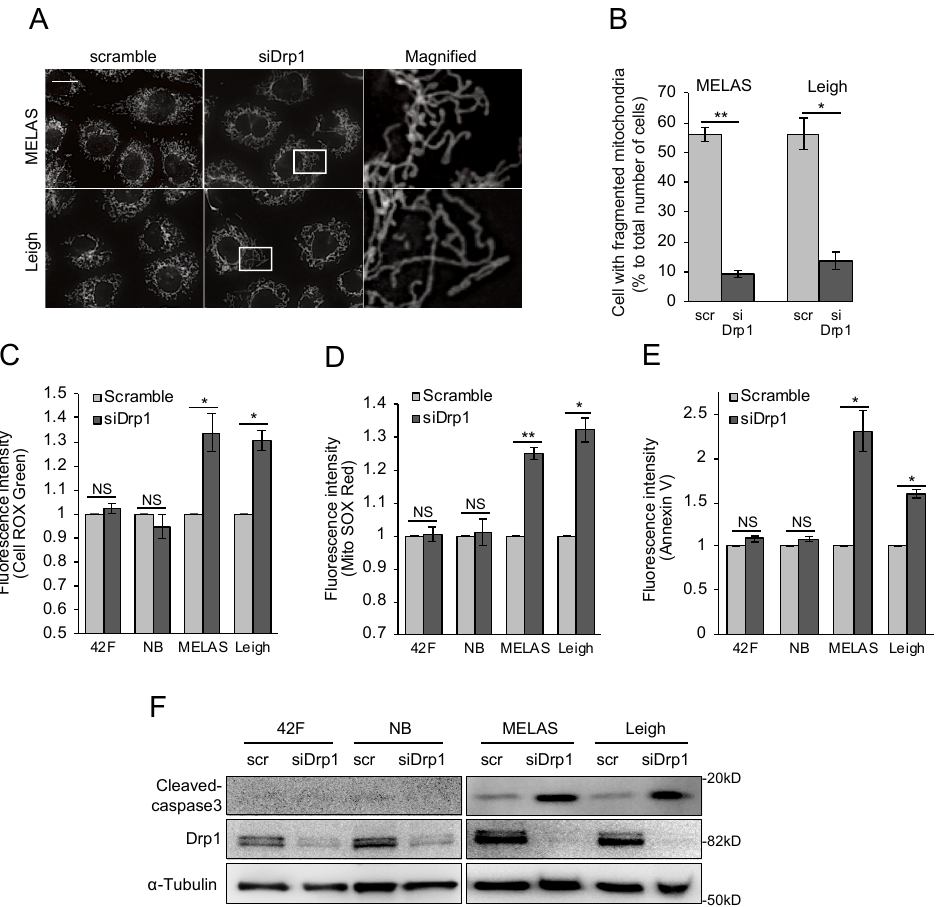
Figure 5. Inhibition of mitochondrial fragmentation triggers cell death in MD fibroblasts. ( A , B ) Drp1 knockdown approximately rescued mitochondrial fragmentation in MD fibroblasts. To visualize mitochondria, cells were stained with anti-Tom20 antibody. Scale bar represents 20 µ m. Quantification was performed from 300 cells per experiment examined in three separate experiments. Error bars represent ± SD. * P < 0.05, ** P < 0.01 (Student’s t -test). ( C , D ) Inhibition of mitochondrial fragmentation promotes intracellular reactive oxygen species (ROS) production in MD fibroblasts. MD fibroblasts were transfected with scrambled and Drp1 small interfering RNA (siRNA) for two days. To analyze oxidative stress, cells were stained with CellROX Green and MitoSOX Red and then analyzed by flow cytometry. Error bars represent ± SD ( n = 3 independent experiments). * P < 0.05 (Student’s t -test). ( E ) Inhibition of mitochondrial fragmentation promotes cell death in MD fibroblasts. Stained with Annexin V-FITC for detection of apoptosis using flow cytometry. Error bars represent ± SD ( n = 3 independent experiments). * P < 0.05, ** P < 0.01 (Student’s t -test). ( F ) Immunoblot shows levels of cleaved caspase-3 in MD fibroblasts transfected or not with Drp1 siRNA for two